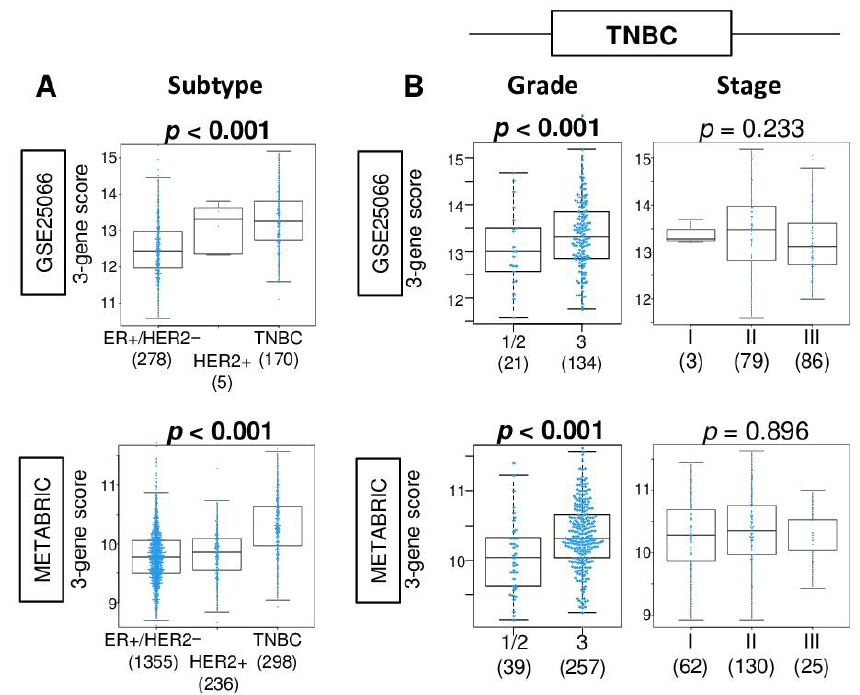
Figure 2. Association of the 3-gene score level with clinical characteristics in the GSE25066 and METABRIC cohorts. Boxplots of the 3-gene score level by ( A ) subtype in the whole cohort, and ( B ) Nottingham pathological grade (grade 1 and 2 vs. grade 3) and American Joint Committee on Cancer pathological stages in TNBC. Correlation plots between the 3-gene score and MKI67 gene expression. The Kruskal–Wallis test or Mann–Whitney U test was used accordingly.